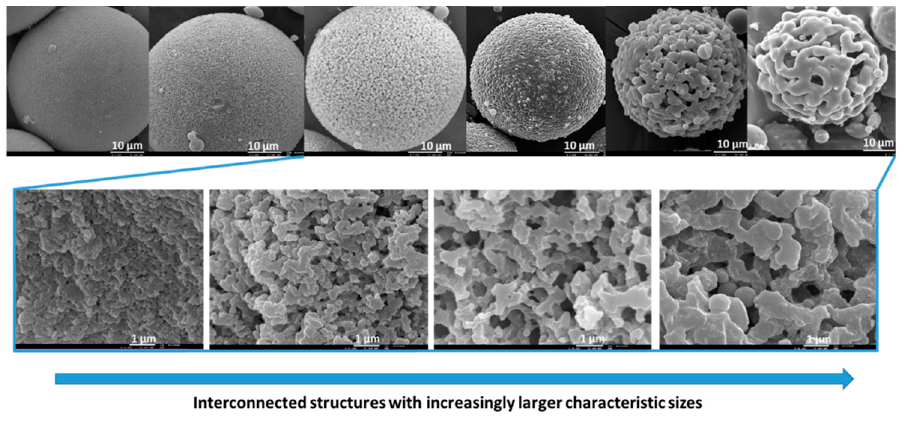
Figure 29. Varied morphologies obtained for MICROSCAFS, synthesized from TEOS and GPTMS, through emulsion combined with sol-gel transition and phase separation, in the absence of any gelation or phase separation inducer additive (A.C. Marques et al., unpublished results).